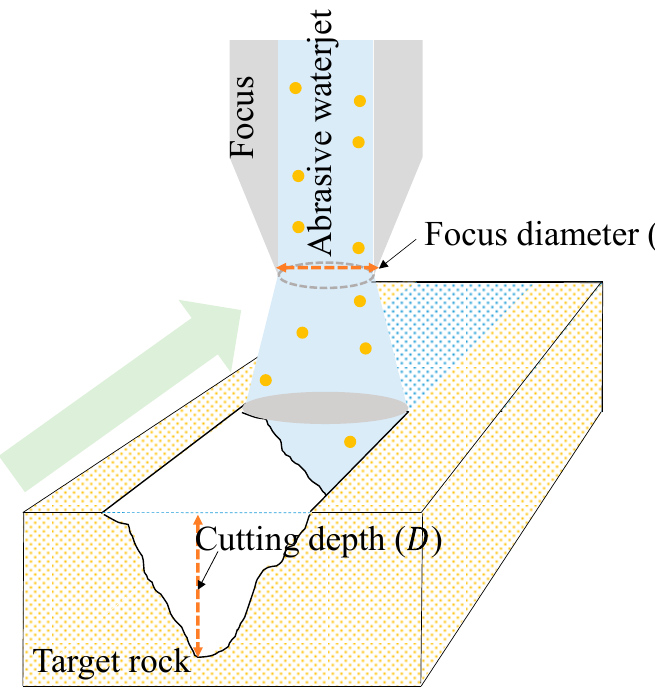
Figure 6. Schematic drawing of abrasive waterjet rock cutting.